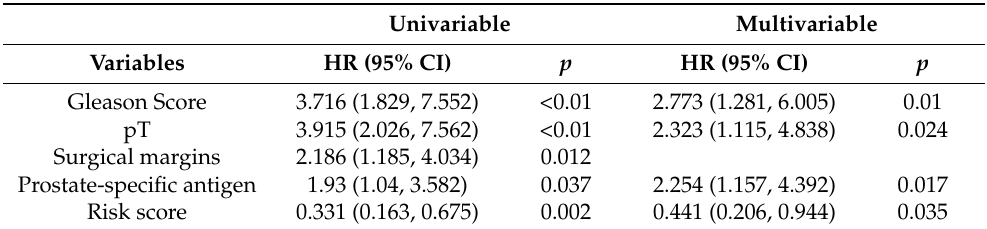
Figure 8. Evaluating the prognostic power of the GS-based four-gene signature in the testing dataset (GSE70769). ( A , B ) Distribution of risk score, BCR status and gene expression of every patient in testing cohort. ( C ) ROC curve analysis of GS-based four-gene signature in testing cohort. ( D ) Kaplan–Meier curve analysis in testing cohort. Table 3. Univariate and multivariate analyses of the four-gene-based risk score and clinicopatho- logical characteristics in GEO70769 validation set .